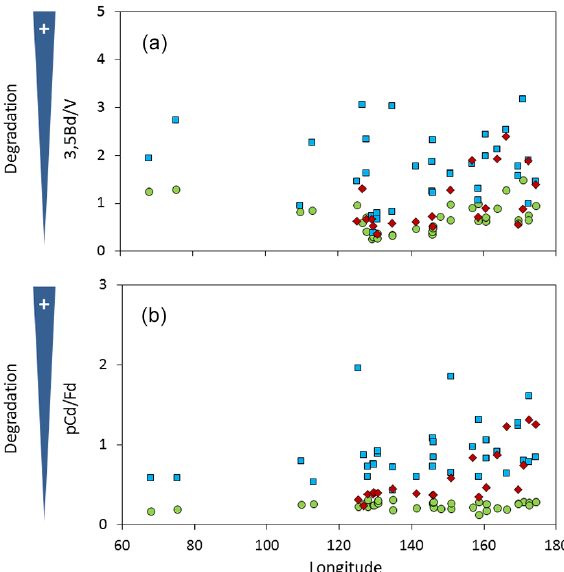
Figure 9. Lignin proxies of Terr-OC and relative degradation state of DOC SPE (green circles), POC (blue squares) and SOC (red dia- monds). (a) Ratios between 3,5-dihydroxybenzoic acid and vanillyl phenols (3,5-Bd / V). (b) Ratios between p -coumaric acid and fer- ulic acid ( p Cd /